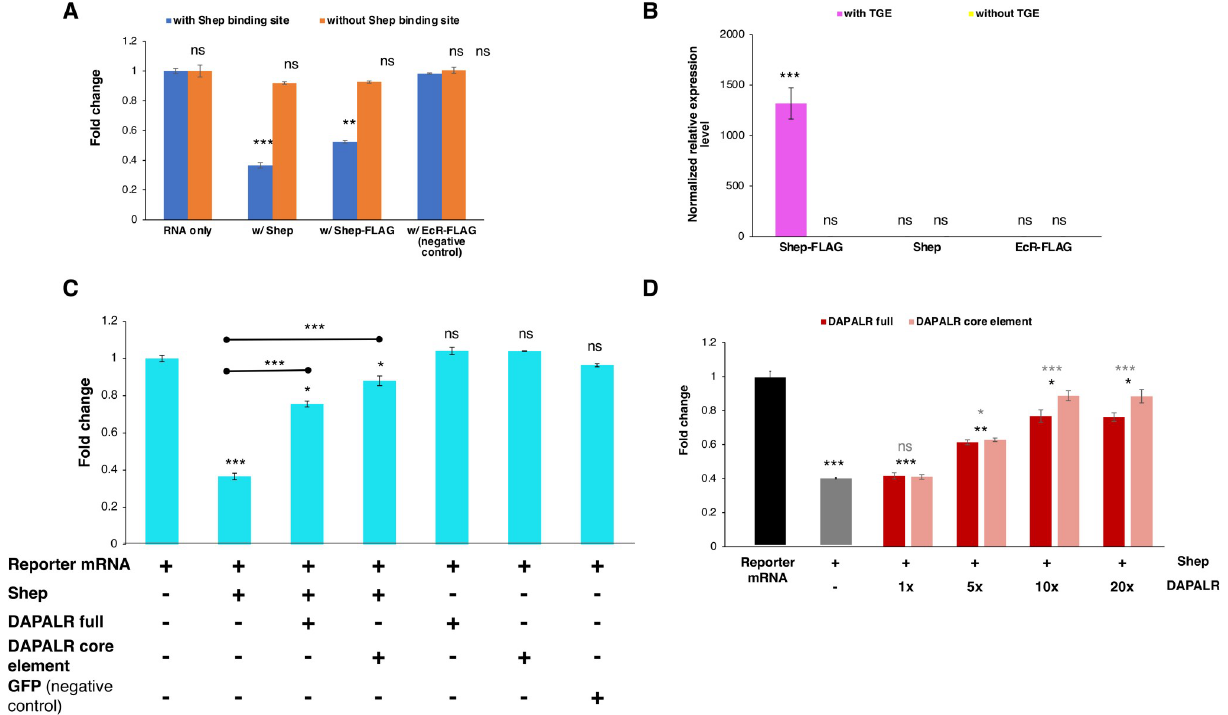
Fig 6. Dsx1 post-transcription regulation by DAPALR and Shep in vitro . (A) Relative luciferase activity after in vitro translation assay of Dsx1 5 0 UTR-Luc reporter mRNA with intact TGE and Dsx1 5 0 UTR-Luc reporter mRNA without the TGE upon addition of Shep mRNA, Shep-FLAG mRNA and EcR-FLAG mRNA (negative control). Samples were compared against the expression of the Dsx1 5 0 UTR-Luc reporter mRNA with intact Shep binding site without the addition of any other mRNAs. (B) Enrichment of the RNAs with and without the TGE after FLAG pulldown assay. Samples are compared against the negative control, RNA without the Shep binding site pulled using EcR-FLAG. (C) Relative luciferase activity after in vitro translation assay of Dsx1 5 0 UTR-Luc reporter mRNA with intact TGE upon addition of Shep mRNA, DAPALR full RNA, DAPALR core element and GFP mRNA (negative control). Samples were compared against the expression of the Dsx1 5 0 UTR-Luc reporter mRNA without the addition of any other mRNAs. The endpoints of the line above the bars show which sample were additionally compared statistically. (D) Relative luciferase activity after in vitro translation assay of Dsx1 5 0 UTR-Luc reporter mRNA with Shep and different concentrations of full region of DAPALR and its core element. Error bars indicate the standard error of the mean, n = 3. Black asterisks show significant statistics compared with the expression of the Dsx1 5 0 UTR-Luc reporter mRNA. Gray asterisks show significant statistics compared with the Reporter mRNA with Shep. Error bars indicate the standard error of the mean, n = 3. � p < 0.05, �� p < 0.01, ��� p < 0.001, ns: not significant (Student’s T-test).